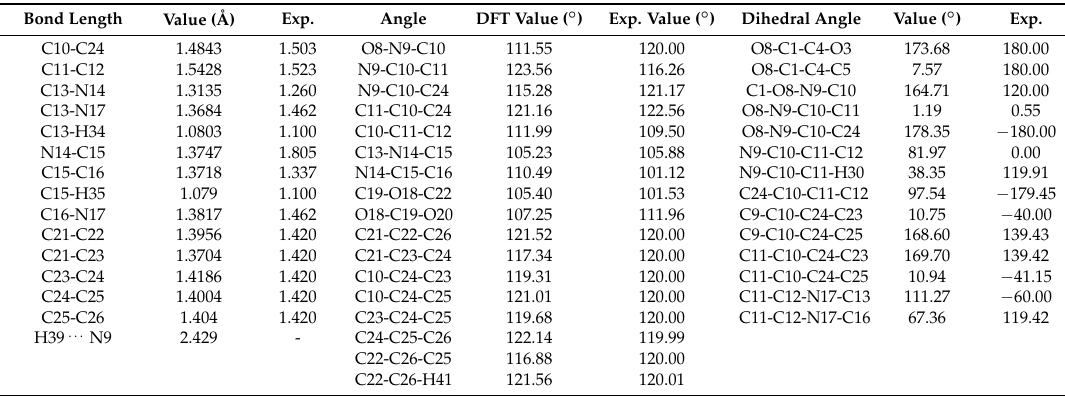
Table 3. The optimized structural geometry parameters for the oximino ester 5